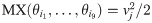
Comparisons of the multiplexing capacities and sensitivities of the base NF-κB and mNF-κB models.(a) The singular values σi of the FIM for the base model and the much larger singular values for the mNF-κB model. (b) The multiplexing capacities MX(θi1,…,θi9)=vj2/2 of the base and mNF-κB models. The parameters with the largest multiplexing capacities correspond to the scaled version of the parameters TNFKB (total amount of NF-κB molecules) and TNFα dose for the base model and TNFKB, pd1 (reverse modification rate of NF-κB) and S2 (signal; treated as parameter here) for the mNF-κB model. (c) The principal sensitivity coefficients of the mNF-κB model. Larger values indicate higher sensitivity of the mNF-κB model to changes in the value of the corresponding parameter. (d,e) Realisations (n = 1000) of the pcLNA distributions of the base and mNF-κB model respectively at three times chosen to correspond to the first three peaks of the deterministic limit (Ω → ∞) of the model. In each case the 6 clusters correspond to different scaled parameter values which are either the scaled base value θ0 or the scaled parameter vector θ0 + δVj, j = 1, …, 5 (δ = 0.1) where V1, …, V5 are the eigendirections of the FIM corresponding to the 5 largest singular values of each model. Thus each cluster of points corresponds to a different principal component. Notice how much better the clusters are separated in the mNF-κB model compared to the base NF-κB model. For the mNF-κB model the base and first three principal component perturbations (black, red, green and blue) are effectively completely separated.